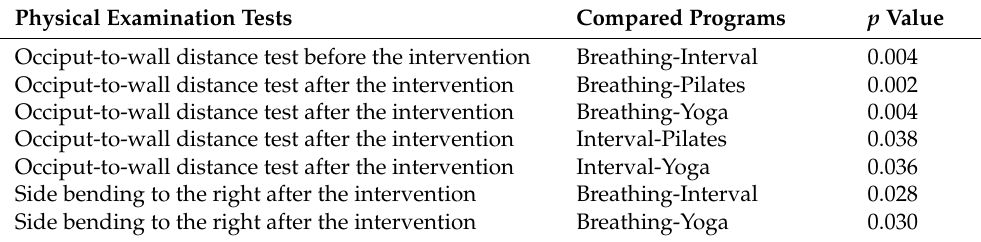
Table 8. Baseline and final pairwise differences among the four motion programmes based on Dunn’s post hoc test.